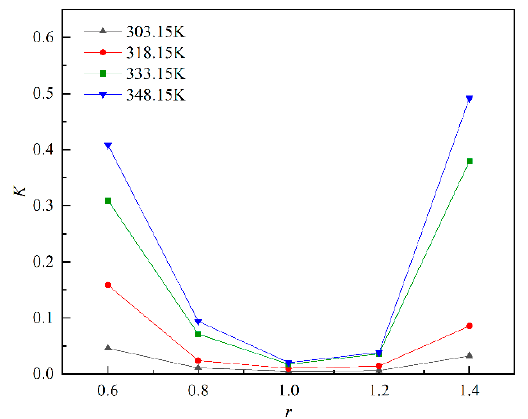
Figure 4. The effect of r on Henry’s coefficient at different temperatures.